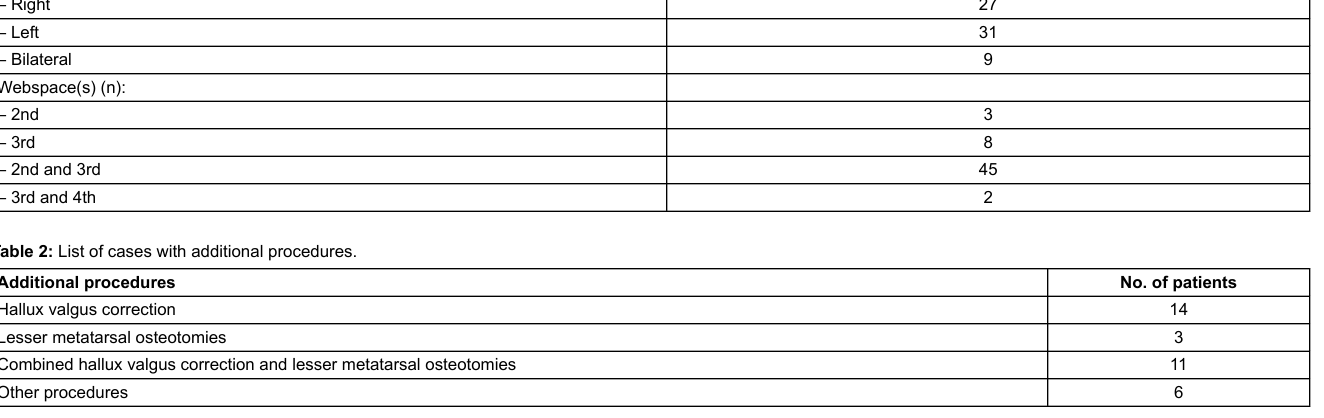
Table 3: Comparison between patients who had undergone neurectomy alone (group 1) and patients in whom additional procedures for the treatment of concomitant foot disor- ders was performed (group 2). Outcome